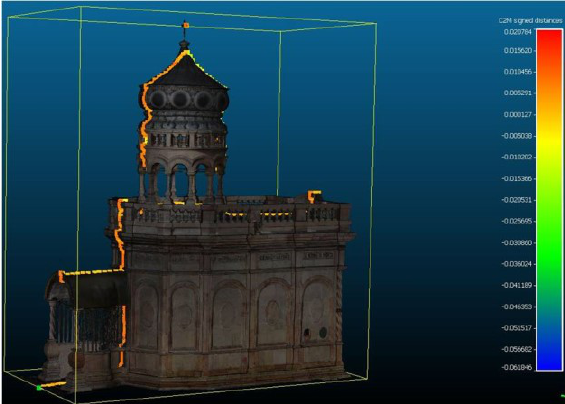
Figure 13: The 2 nd vertical section and its deviations from the reference